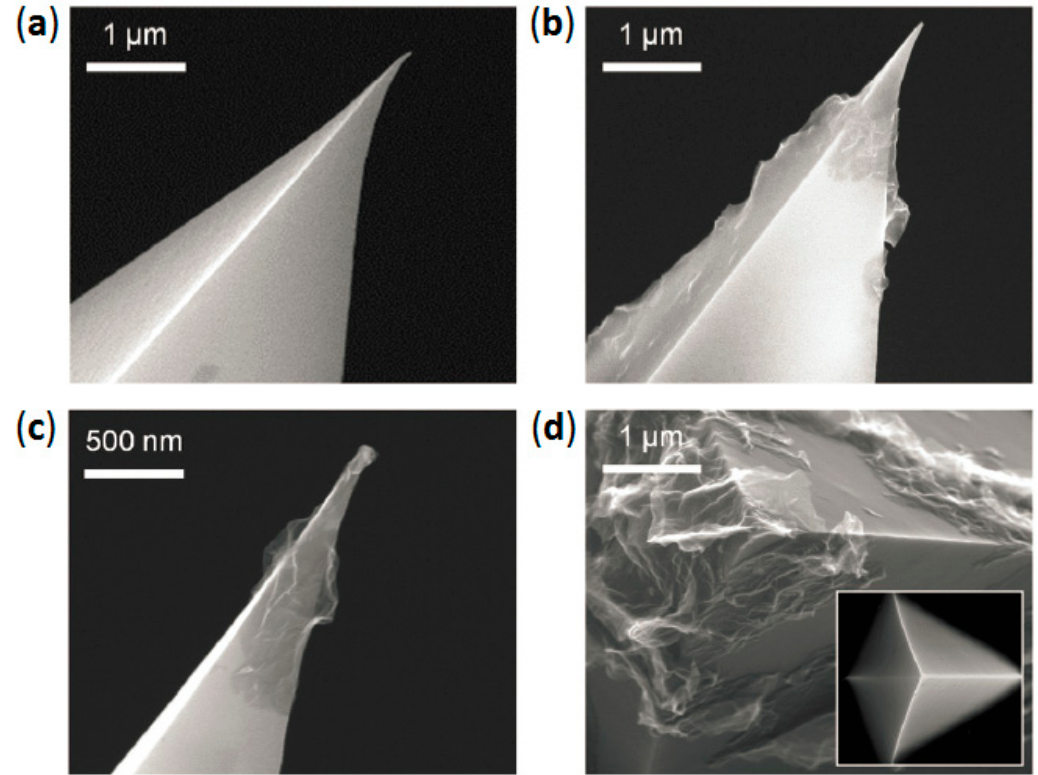
Figure 5. Different commercial Pt-varnished AFM probes coated by solution processed graphene flakes. SEM images of as-received OMCL-AC240 nanoprobe before ( a ) and after coating ( b ); ( c , d ) are OSCM-PT and SCM-PIC AFM nanoprobes coated with low density of graphene sheets (respectively). Reproduced with permission from [28], copyright The Royal Society of Chemistry (2016).